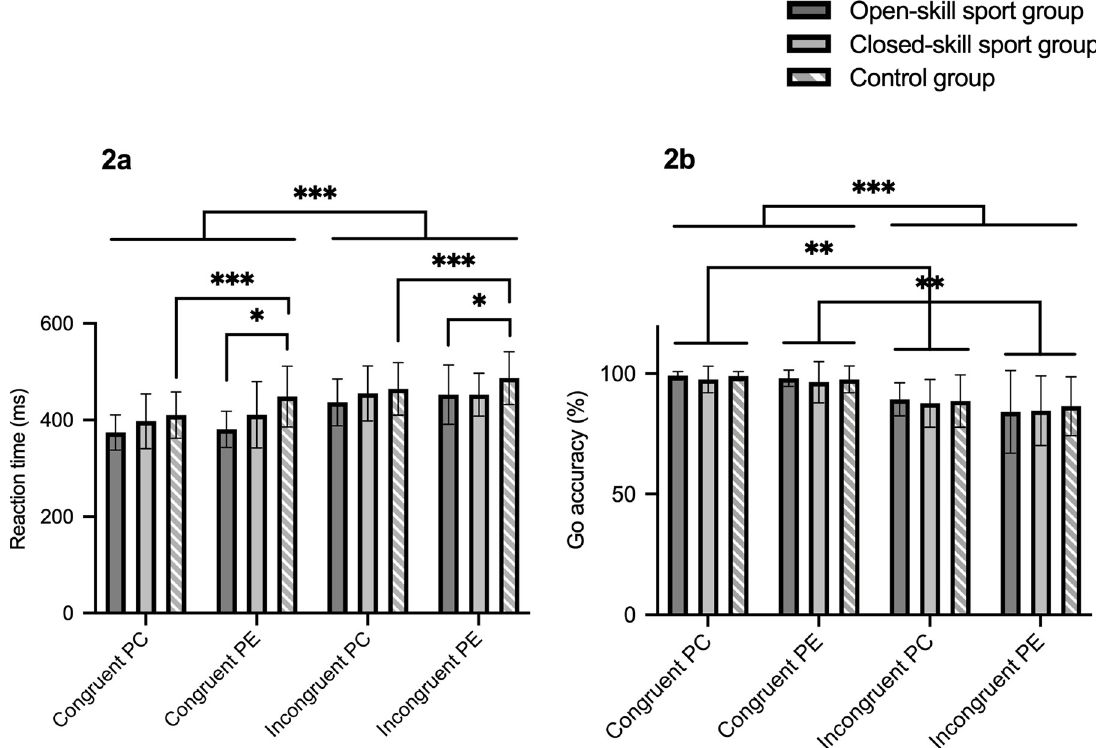
Fig 2. Mean and SD of (a) post-correct and post-error RTs and (b) post-correct and post-error accuracies across congruent and incongruent conditions for open-skill sport group, closed-skill group, and control group; PC = post-correct; PE = post-error; ��� represents the p -value � 0.001; �� denotes the p -value � 0.01; � refers to the p -value � 0.05.